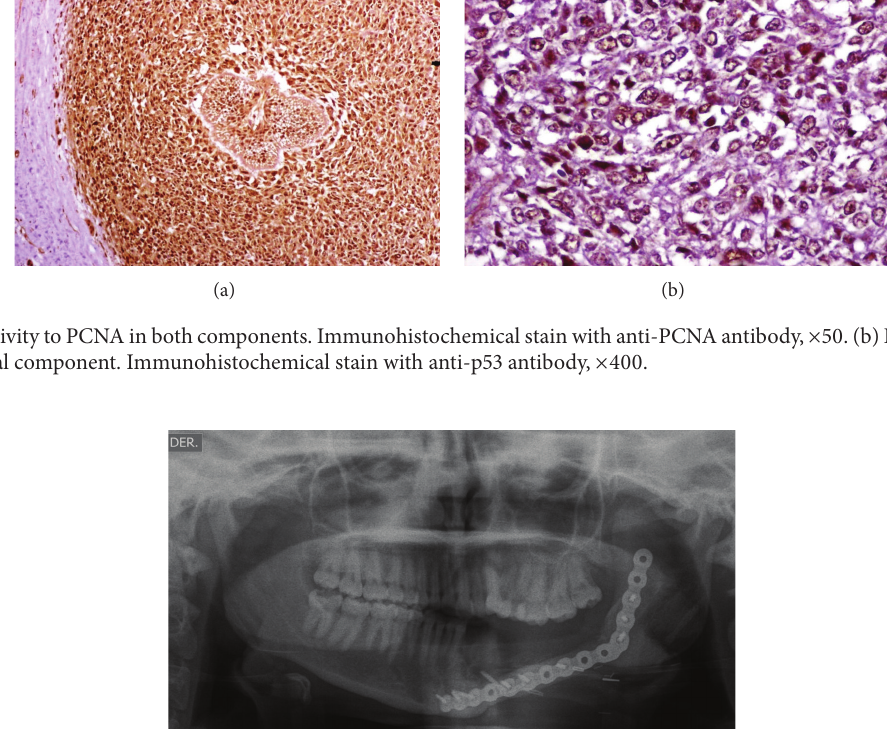
Figure 7: Panoramic radiograph showing area of mandibular resection with no evidence of recurrence 1 year after